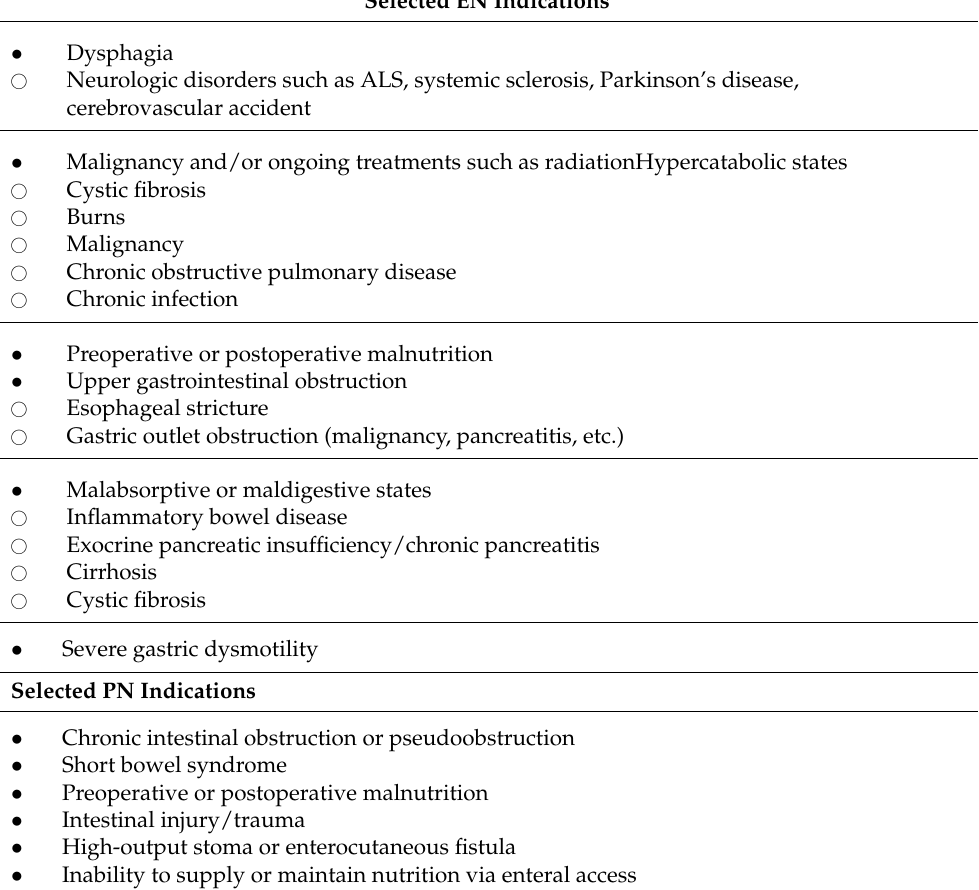
Table 1. Indications for